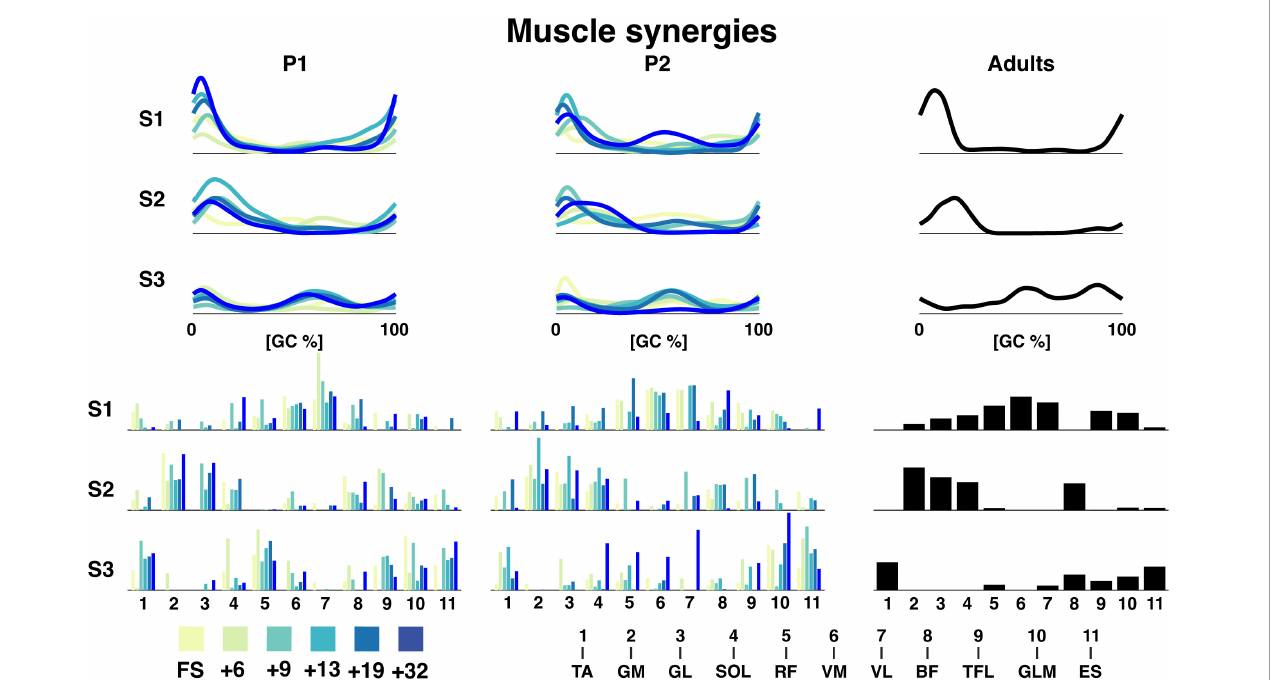
FIGURE5 Muscle synergies for P1, P2, and adults. The top graphs are the grand average temporal activation patterns for each session as a function of the gait cycle and the three synergies. Amplitude is in arbitrary units. The lower bar graphs are the weighting coefficients for the muscle synergies. The naming of the muscles can be seen below. TA: tibialis anterior, GM: gastrocnemius medialis, GL: gastrocnemius lateralis, SOL: soleus, RF: rectus femoris, VM: vastus medialis, VL: vastus lateralis, BF: biceps femoris, TFL: tensor fascia latae, GLM: gluteus maximus, ES: erector spinae, +6, +9, +13, +19, +32 refers to the number of months since onset of independent walking.